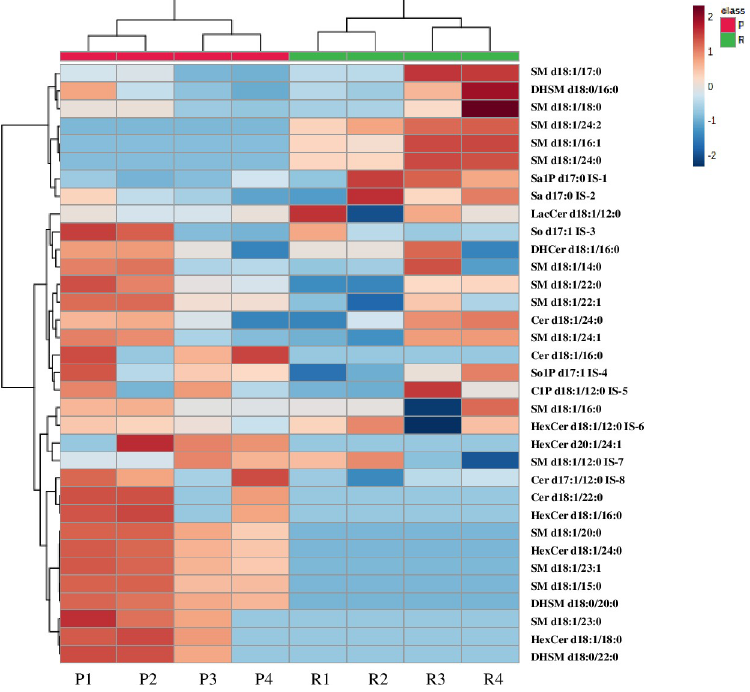
Fig 2. Heatmap showing the levels of SPLs in parental and dox-resistant MCF7 cells. The columns represent the type of cell line (P1-4 represents parental MCF-7 independent samples) and (R1-4 represents dox-resistant MCF-7 independent samples), while the rows represent the SPLs species. The color scale from blue to maroon represented the reduction and elevation in the levels of SPLs with respect to the median value of the intensity level. The red color indicated parental MCF-7 cells, while green indicated dox-resistant MCF-7 cells.